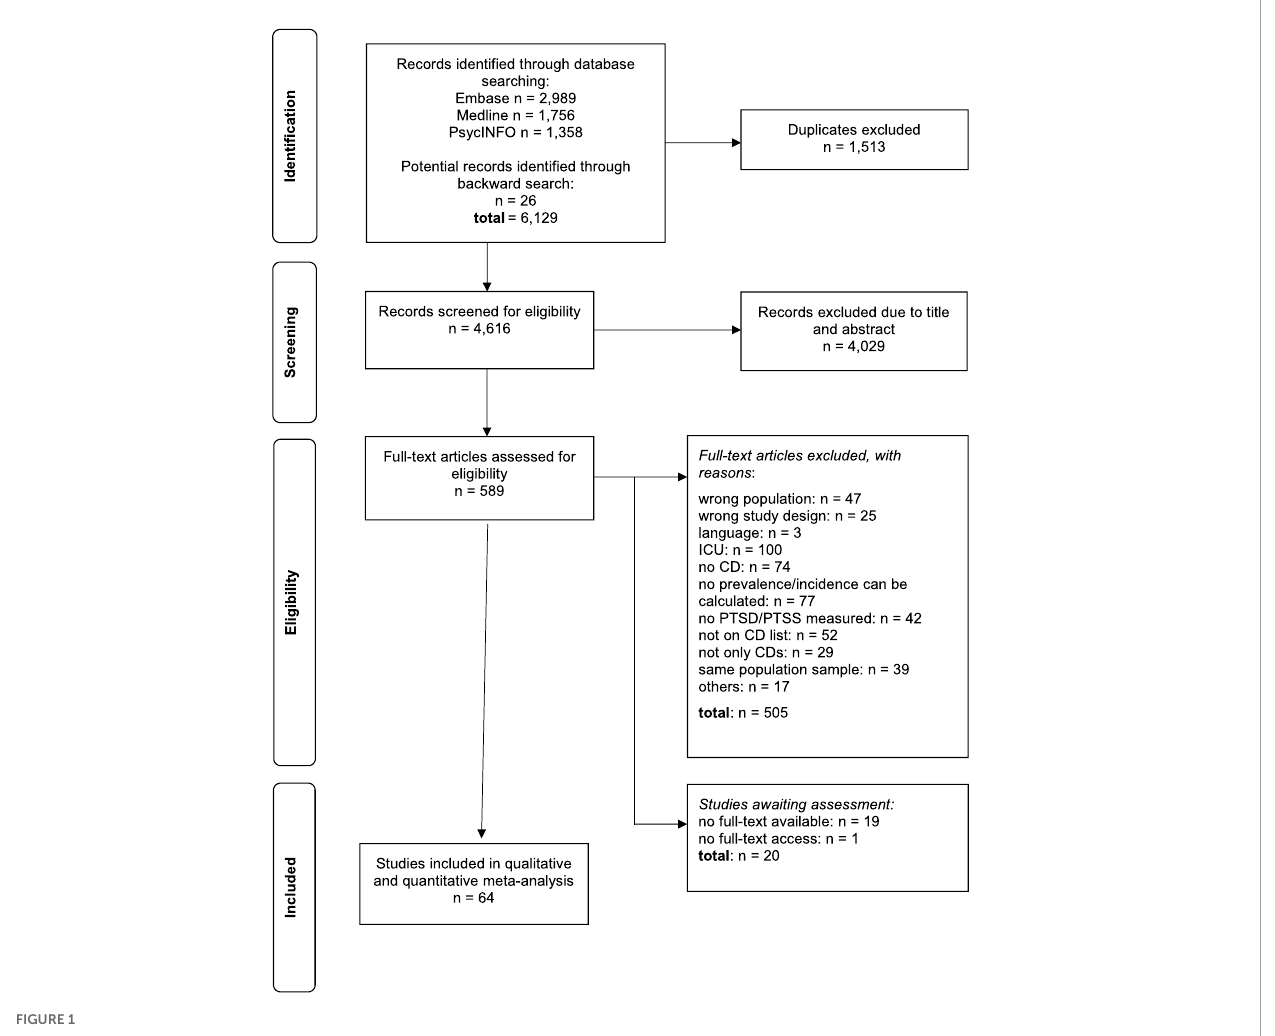
FIGURE1 Selection process of primary